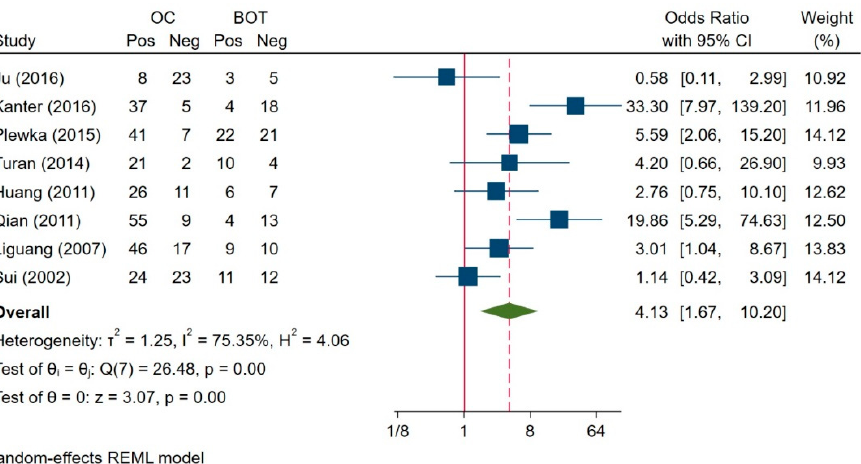
Figure 4. Comparison of survivin expression between ovarian carcinoma and borderline ovarian tumour [3,7,31–33,36,38]. Abbreviations: OC =Ovarian Cancer; BOT = Borderline Ovarian Tumour; REML = The Restricted Maximum Likelihood.